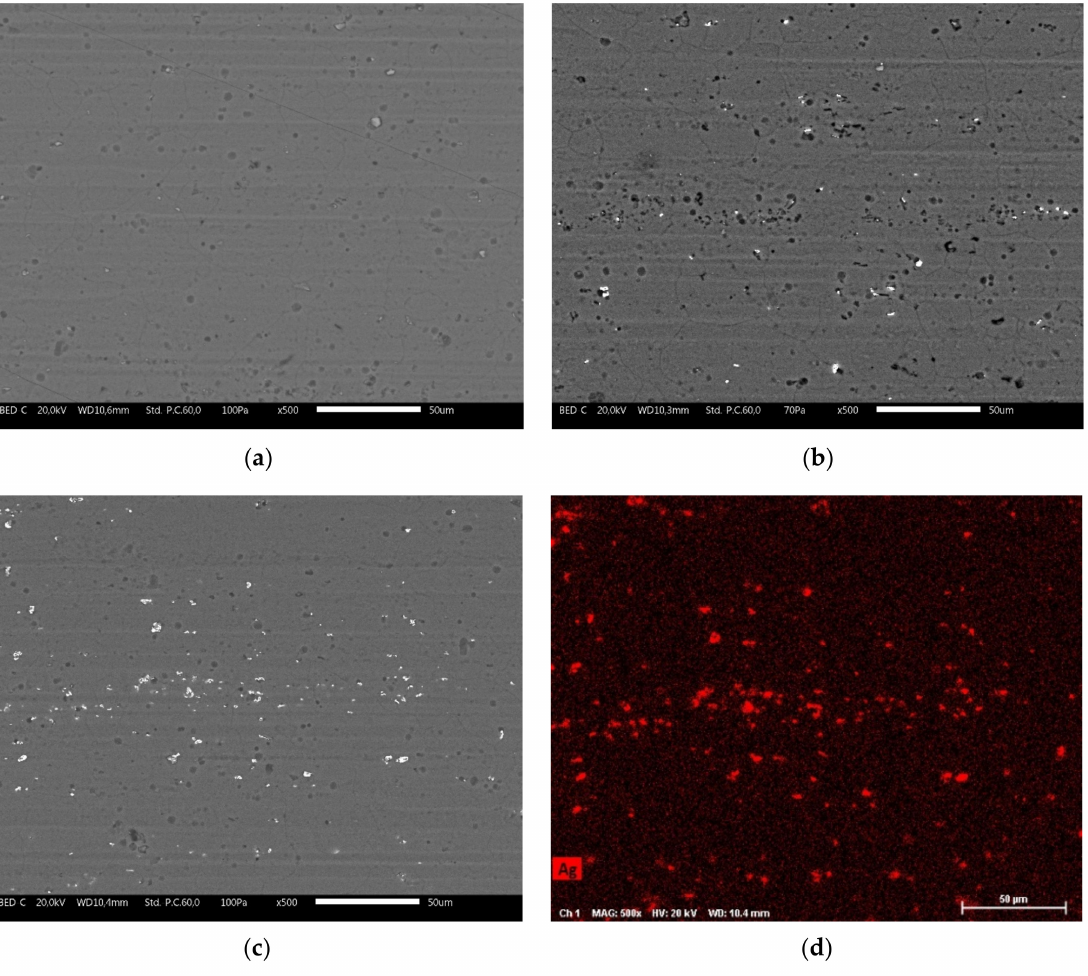
Figure 3. SEM micrographs of the surface of sample X ( a ), sample A ( b ) and sample B ( c ), respectively. ( d ) represents the Ag EDXS map relative to ( c